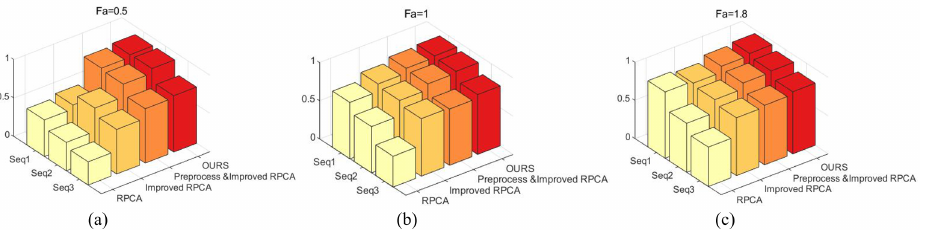
Figure 13. Probability of detection for the ( a ) F a = 0.5, ( b ) F a = 1, ( c ) F a = 1.8. Table 4. Probability of detection for the ablation